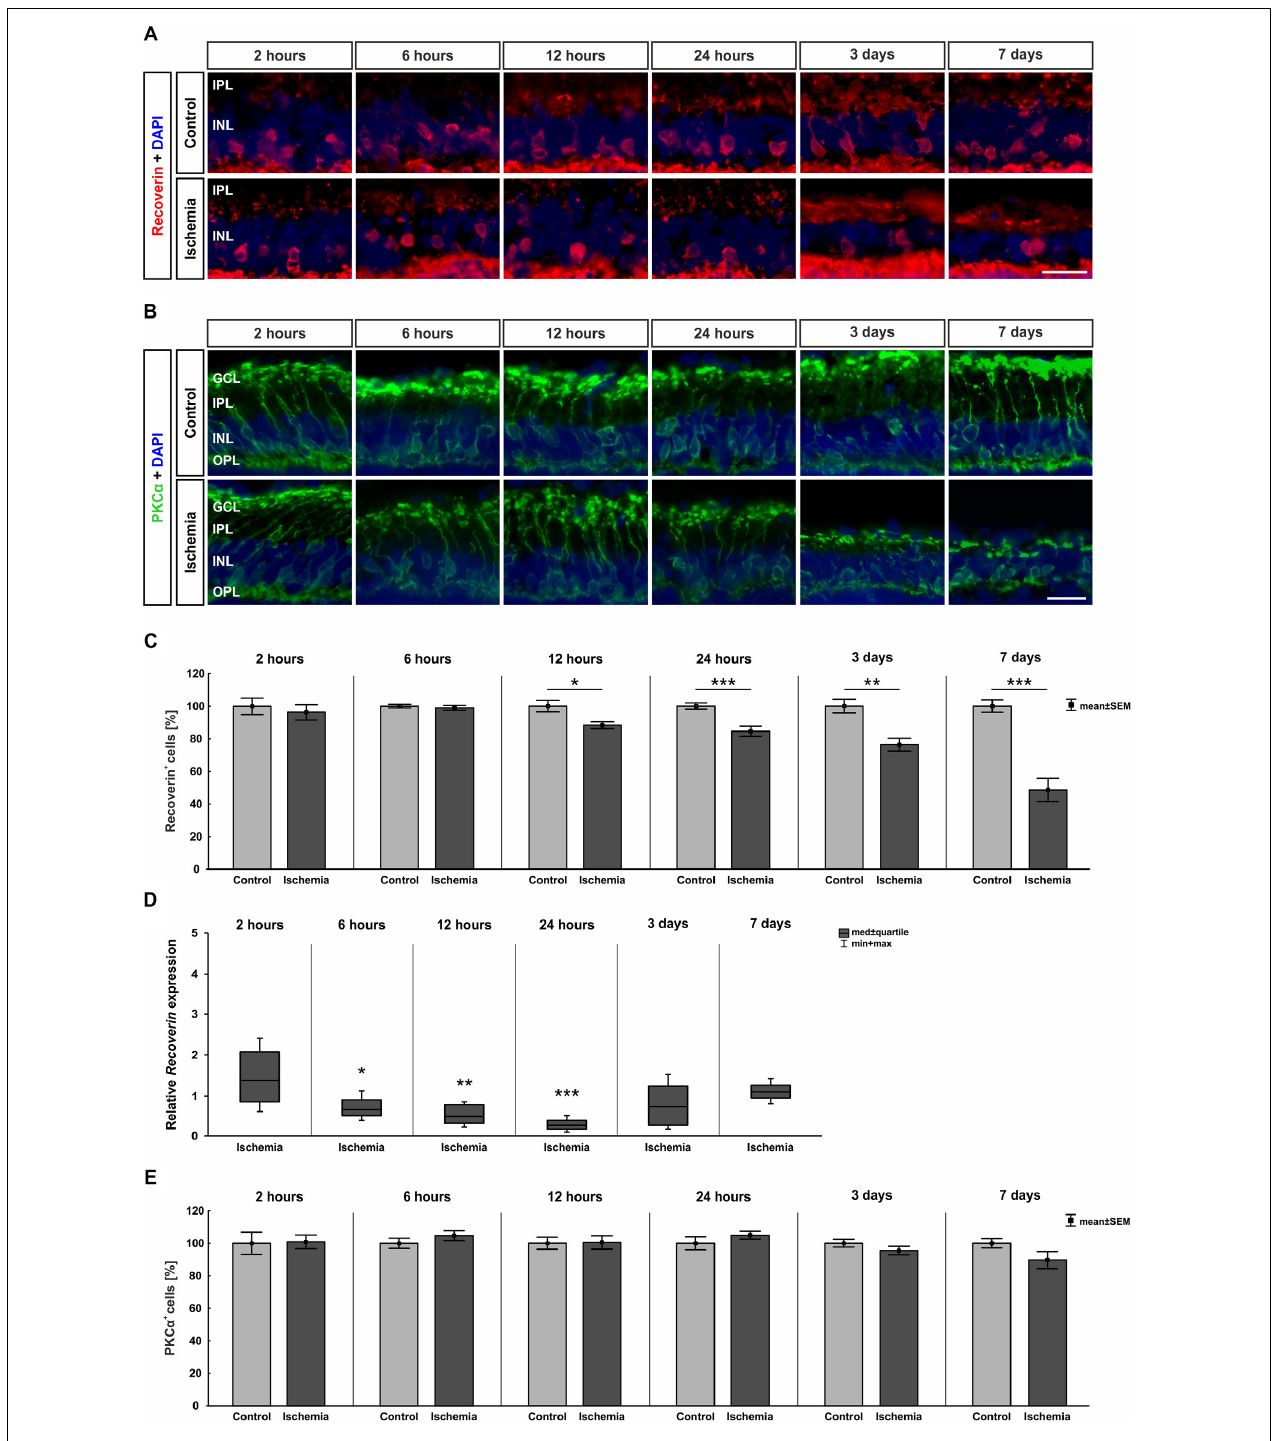
FIGURE 5 | (A) Cone bipolar cells were stained with anti-recoverin (red) and cell nuclei with DAPI (blue; n = 7–8/group). After ischemia induction, fewer cells were observed over time. (B) Anti-PKC α was used to detect rod bipolar cells (green) and DAPI for cell nuclei (blue; n = 7–8/group). The cells were equally stained in both groups. (C) Counting of cone bipolar cells displayed a significant reduction of recoverin + cells at 12 h ( p = 0.015), 24 h ( p < 0.001), 3 days ( p = 0.001), and 7 days ( p < 0.001) after ischemia induction. (D) On mRNA level, a significant down-regulation of Recoverin mRNA expression was shown in the ischemia group at 6 h ( p = 0.024), 12 h ( p = 0.006), and 24 h ( p < 0.001). (E) Evaluation of rod bipolar cells revealed no differences in cell number between both groups and all points in time. ∗ p < 0.05, ∗∗ p < 0.01, ∗∗∗ p < 0.001. GCL, ganglion cell layer; IPL, inner plexiform layer; INL, inner nuclear layer; OPL, outer plexiform layer. Scale bars: 20 µ